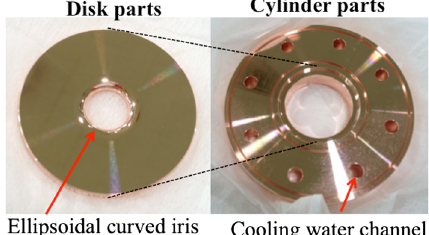
FIG. 4. Disk (left) and the cylinder (right) of the accelerating cell.